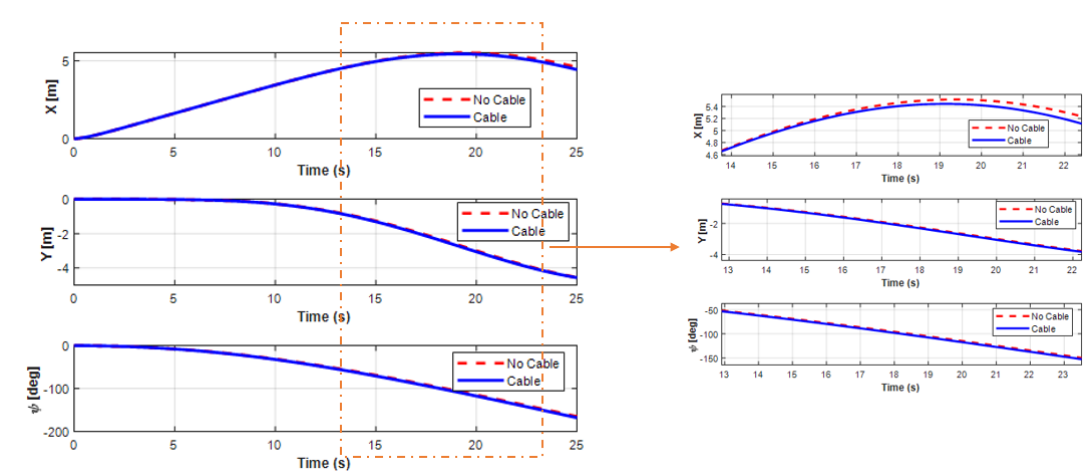
Figure 23. Simulation results of the position behaviors in the USV turning motion.